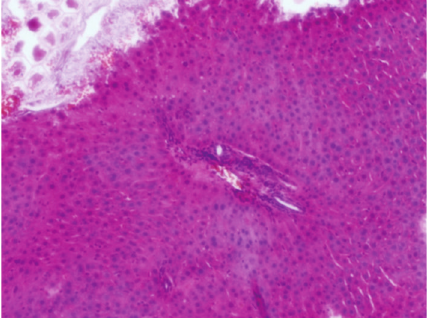
Figure 12: Focal areas with parenchymal loss and haemorrhage in the liver from a rat of the DSS group.